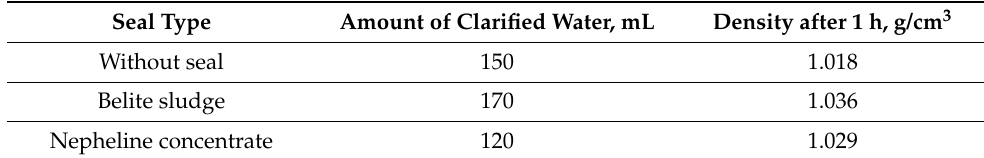
Table 4. Results obtained after compaction of the thickened